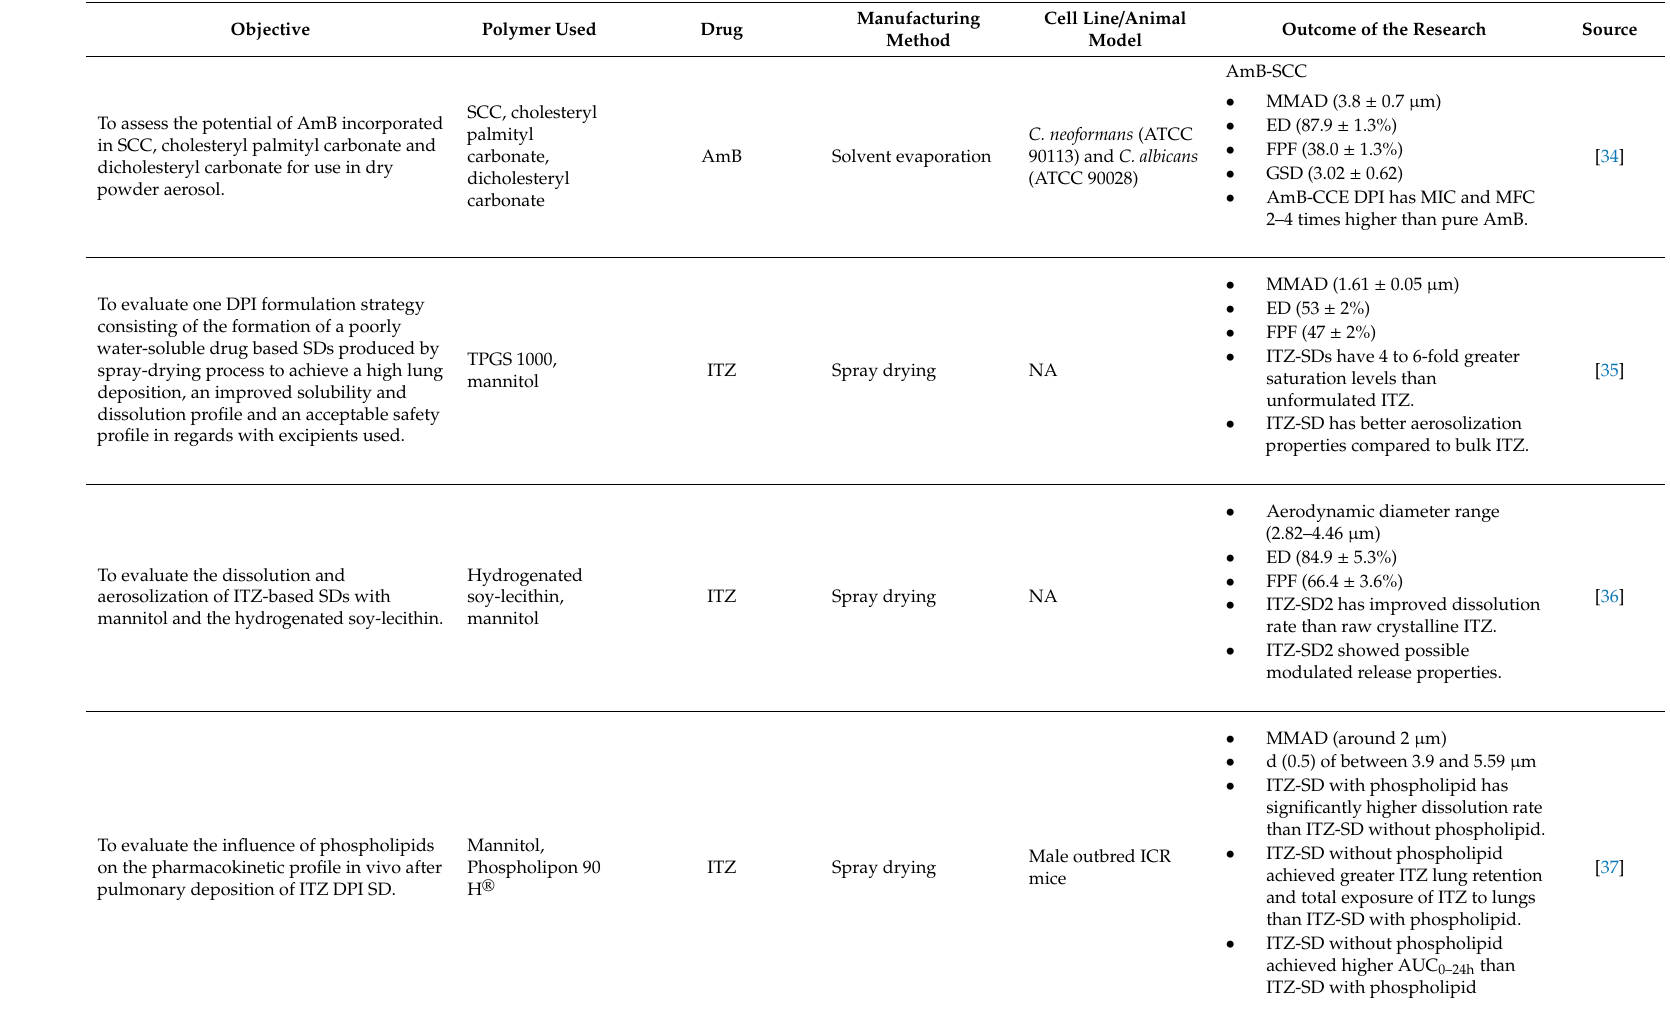
Table 1. Micronized drugs administered as dry powders for lung